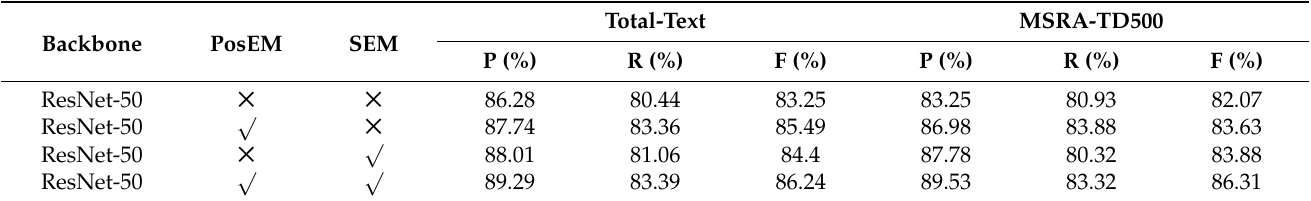
Table 1. Results of the ablation experiments on the Total-Text and MSRA-TD500